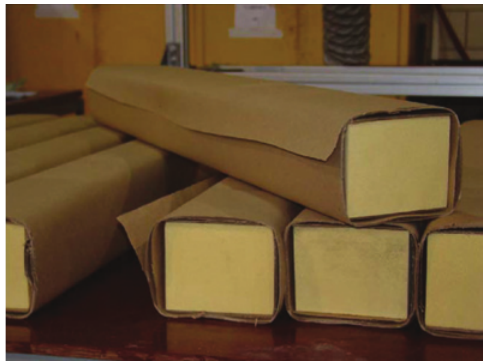
Figure 14: Paper wrapped on foam core ready to be assembled in the preform